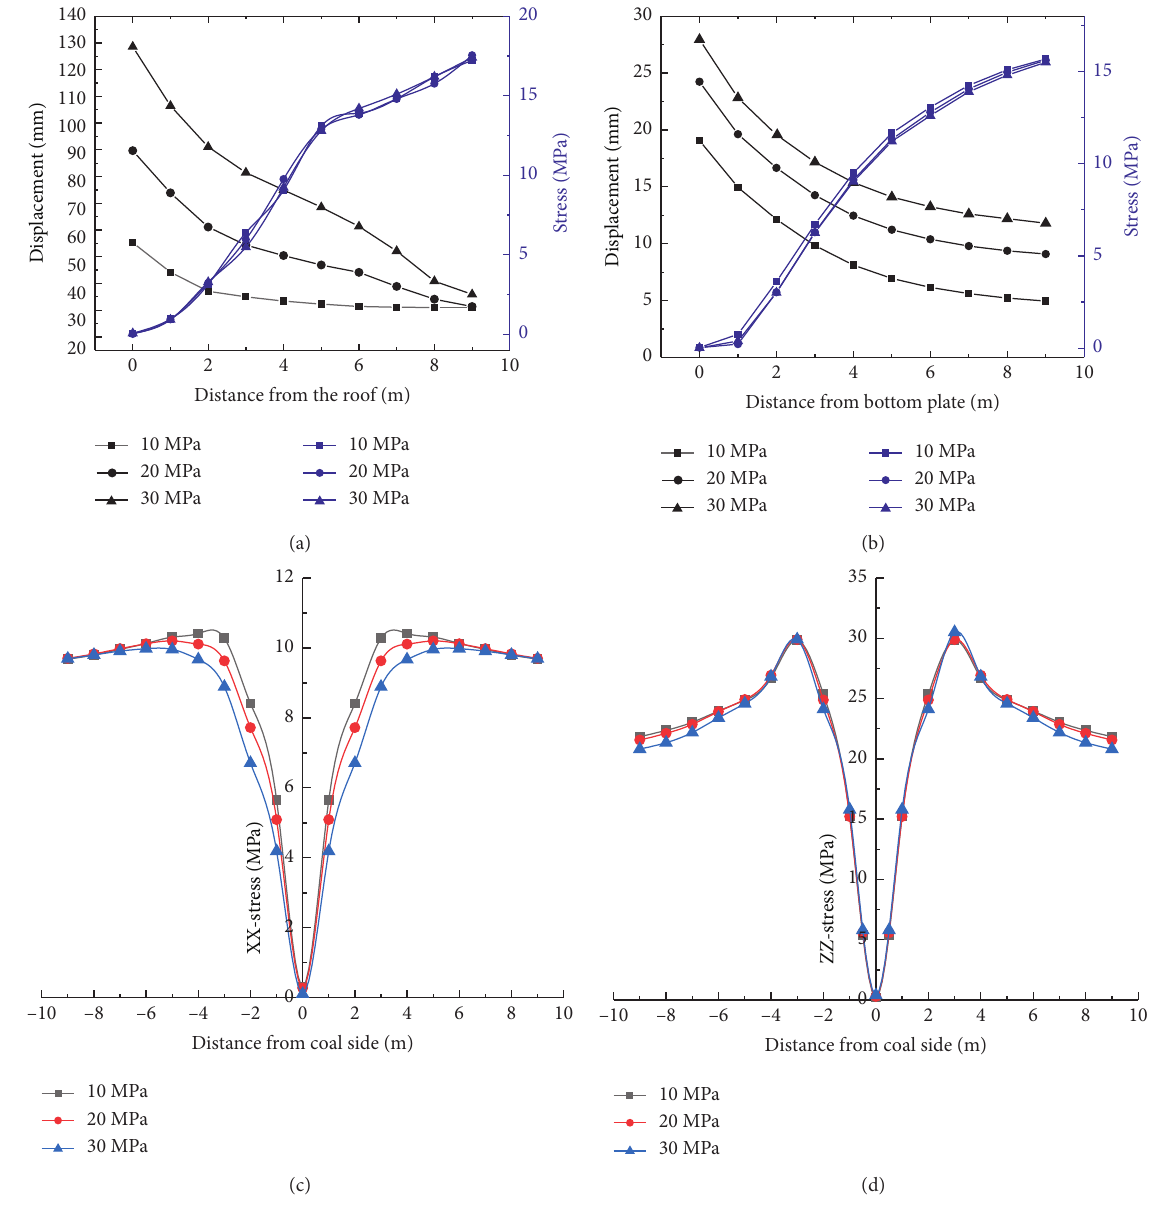
Figure 10: Deformation law of surrounding